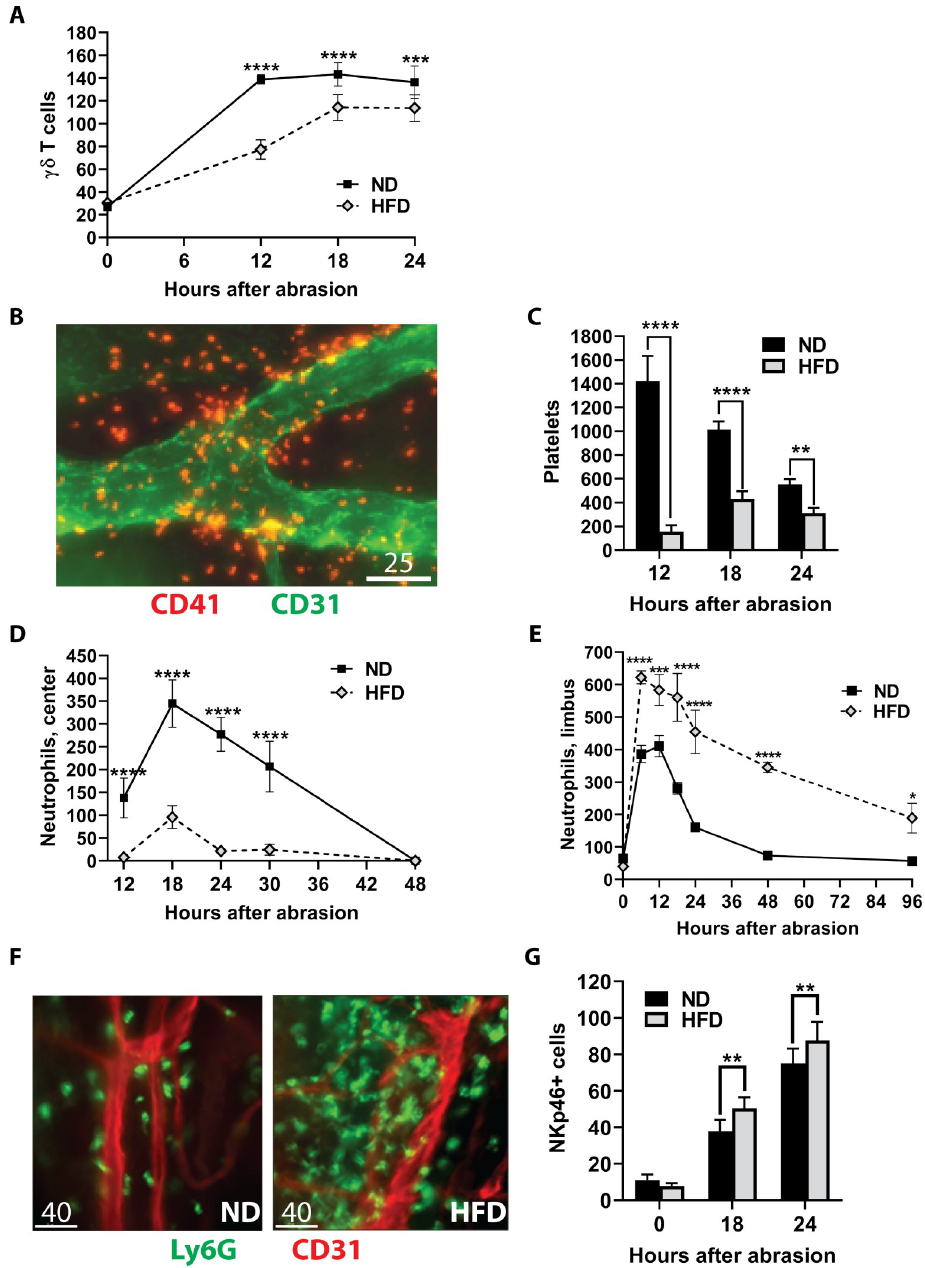
Fig 6. Effect of the HFD on corneal responses to central epithelial abrasion. Corneas from ND and HFD fed mice were analyzed after epithelial abrasion. (A) γδ T cells were counted in the epithelium and stroma across the cornea and plotted at 0, 6, 12, and 18h after epithelial abrasion (n = 6 per group). (B) Representative micrograph of extravascular platelets (red) around the limbal vascular network (green) at 12h after injury in a mouse fed a ND. Scale bar = 25 μ m. (C) The sum of platelets in eight random non-overlapping 40X fields of view in the corneal limbus determined at 12, 18 and 24h after corneal abrasion (n = 4 at each time point). (D) Kinetics of neutrophil influx into the central abraded area of the cornea (counts from four 40X fields in the center of the cornea, n = 8 at each time point) are plotted at 12, 18, 24, 30, and 48h after abrasion. (E) Kinetics of neutrophil influx into the corneal limbus (counts from eight 40X fields in the limbus, n = 4–8 at each time point) prior to wounding (0h) and at 6, 12, 18, 24, 48, and 96h after abrasion. (F) Representative micrographs of neutrophil (green) influx around the limbal vascular (red) network at 48h after injury. Scale bar = 40 μ m. (G) Limbal stromal NK cell counts (determined from nine vertical and horizontal 40X fields across the cornea, n = 8 per group) without wounding (0h), and at 18 and 24h after epithelial abrasion. Data shown as means ± SD. � p < 0.05, �� p < 0.01, ��� p < 0.001, ���� p <